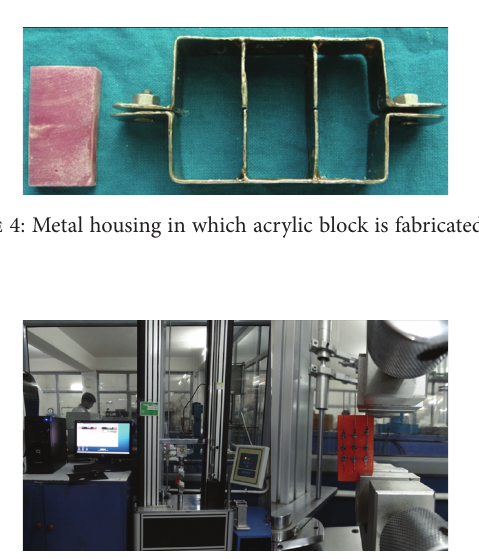
Figure 5: Custom made assembly mounted on the machine; test wire is being pulled in upward direction (universal testing machine, Blue Star, model number HZ